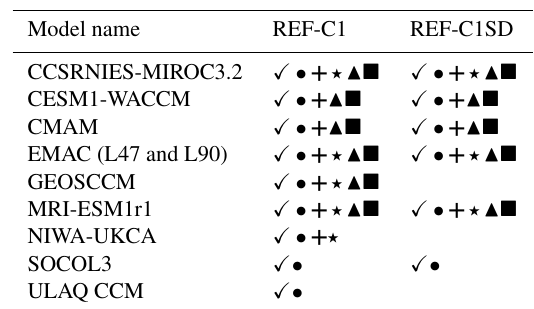
Table 3. Available TEM-related model output for each model from the CCMI-1 archive: w ∗ ( (cid:88) ), v ∗ ( • ), EPFD ( + ), gravity wave drag (OGWD and NOGWD; (cid:63) ), OGWD ( (cid:78) ), and NOGWD ( (cid:4)